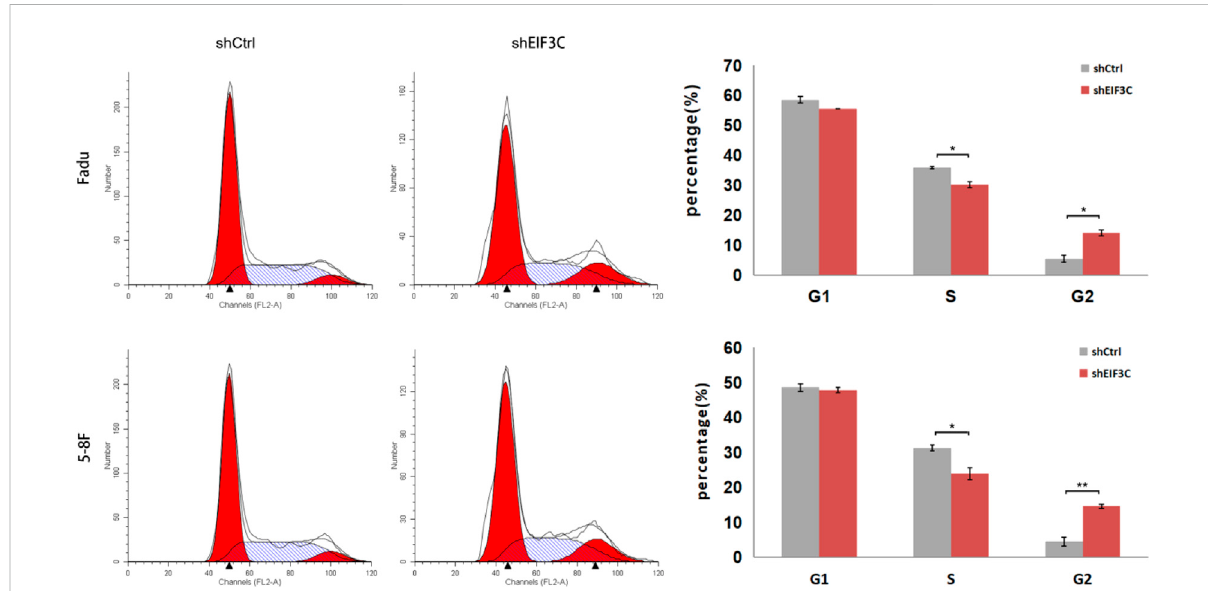
FIGURE 5 The L.v-shEIF3C triggered cell cycle arrest in FaDu and 5-8F cells. The fl ow cytometry analysis showed that the number of cells increased in G2 phase and decreased in S phase in L.v-shEIF3C group compared with the L.v-shCtrl group. The data is the means ± SDs of three independent experiments. The differences were statistically signi fi cant. * p <